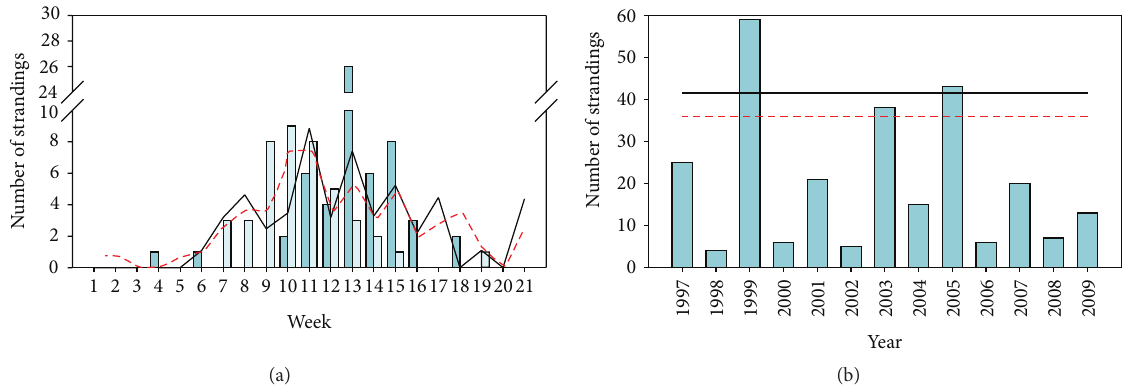
Figure 2: (a) Weekly harbor porpoise strandings in 1999 (darker blue bars) and 2005 (lighter blue bars) compared to weekly threshold A (mean + 2 standard deviations: 1997-1998, 2000–2004) (black horizontal solid line) and threshold B (mean + 2 standard deviations: 1997- 1998, 2000–2004, 2006–2009) (red horizontal dashed line). (b) Annual harbor porpoise strandings during 1997–2009 (blue bars) compared to annual threshold A (black horizontal solid line) and threshold B (red horizontal dashed